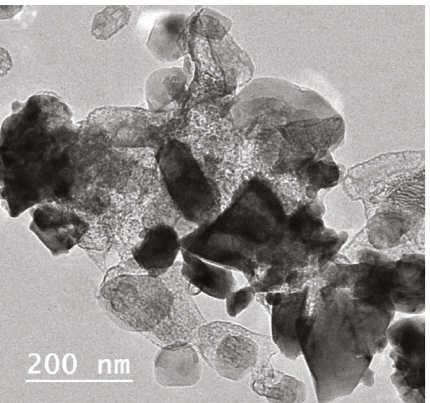
Figure 19: TEM image of Nd